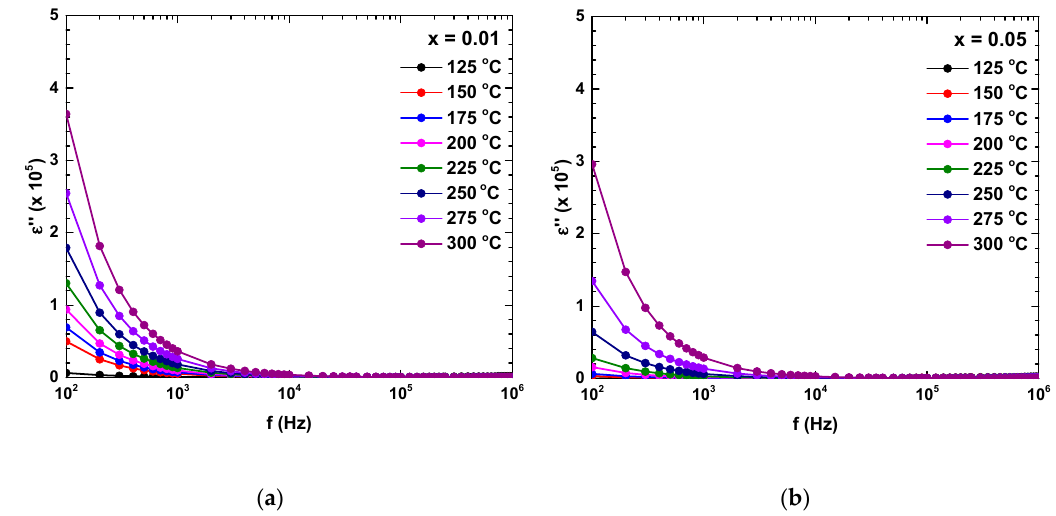
Figure 7. Dielectric constant, ε (cid:4593) (cid:4666)f(cid:4667), of LaFe 1 − x Zr x O 3 with ( a ) x = 0.01 and ( b ) x = 0.05 annealed at 800 °C for 6 h at different temperatures.